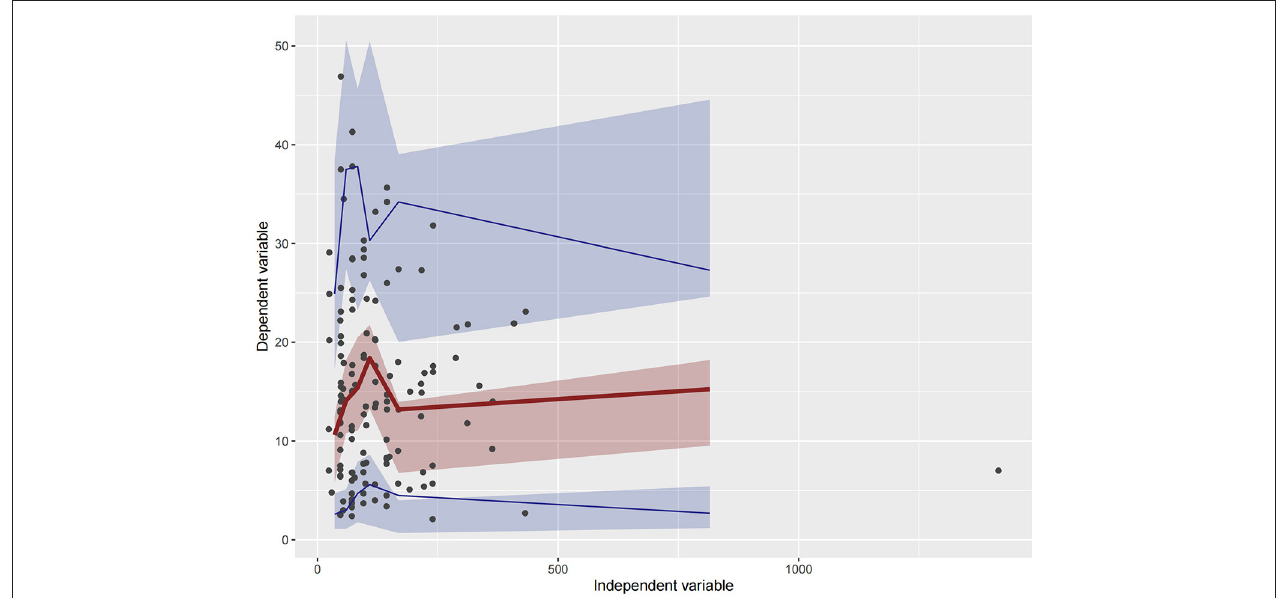
FIGURE 4 | Visual predictive check (VPC) of Model 1. Circles represent observations. The red solid lines represent the median of simulated concentrations, and the blue solid lines represent the 90% PI (5 and 95%) of the predictive vancomycin concentrations. The shaded areas represent the 95% CI for each line.